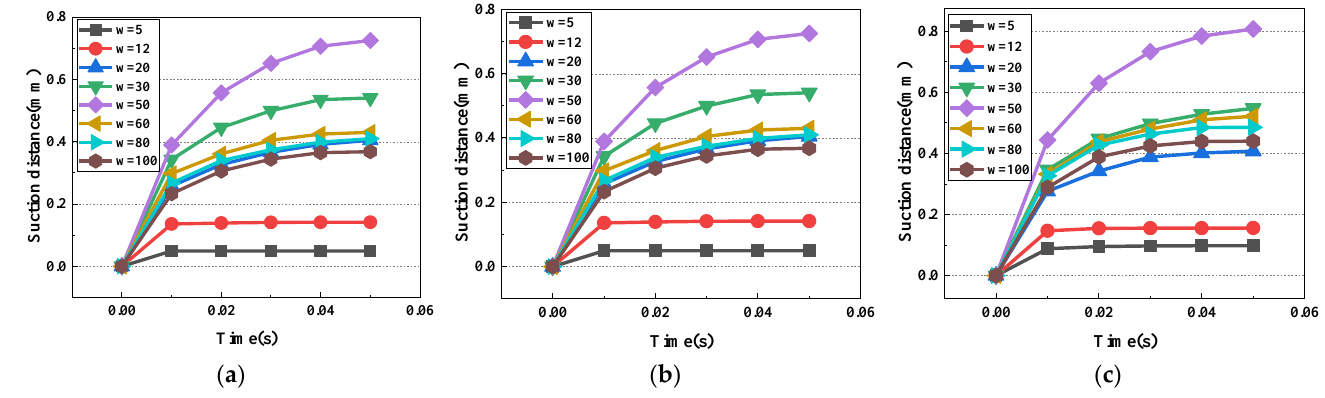
Figure 7. Capillary suction process in array microchannels of different depth. ( a ) 150 μm ; ( b ) 180 μm ; and ( c ) 200 μm .